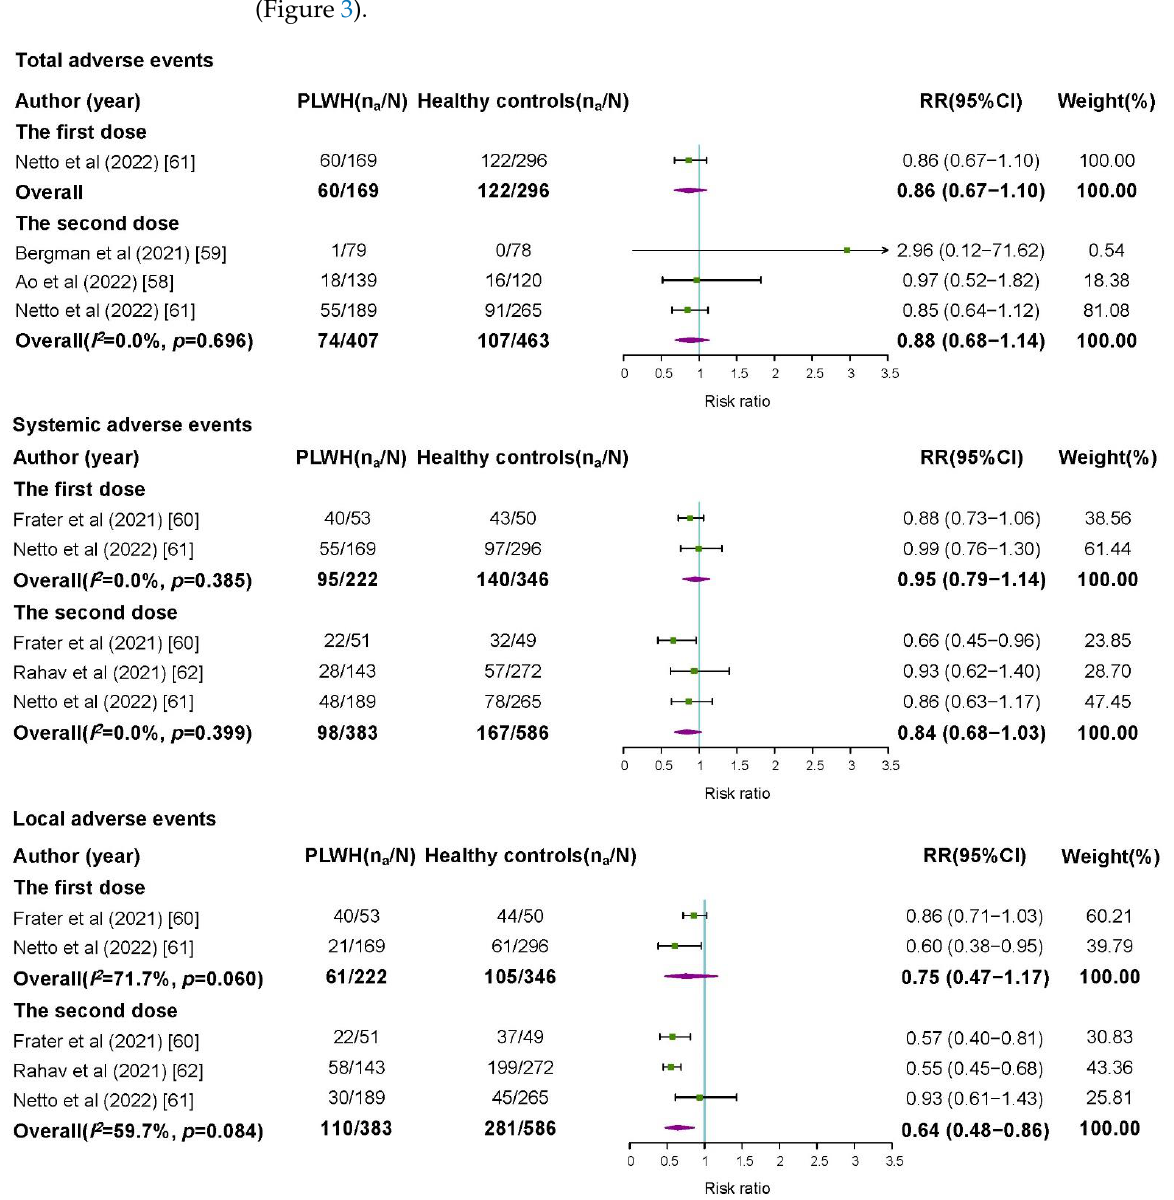
Figure 3. Risk ratios for adverse events among people living with HIV compared with healthy controls after a first or second dose of COVID-19 vaccine. PLWH: people living with HIV; n a : number of people reported adverse events; N: group size; RR: risk ratio; CI: confidence interval.